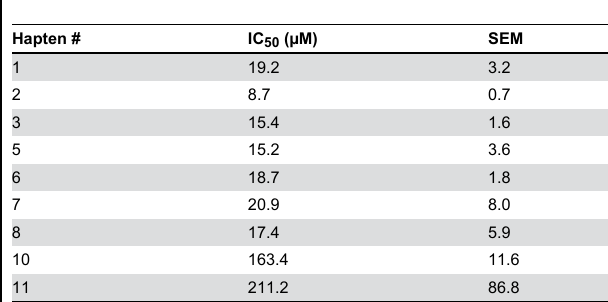
Table 3. Relative Affinity of Anti-Nicotine Antibodies induced by Different Hapten-DT Conjugates in